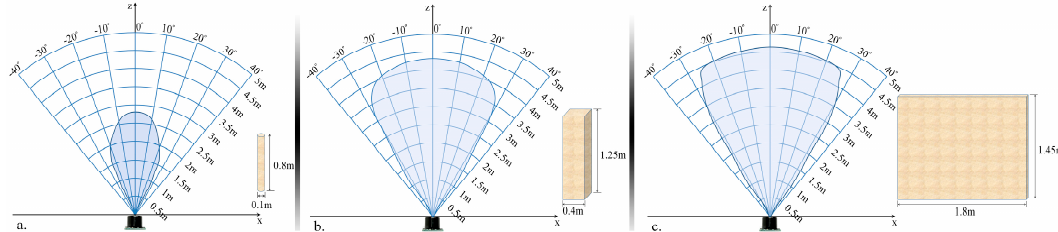
Figure 6. Evaluation of the sensor sonar field of view using: ( a ) a cylinder (10 cm diameter and 85 cm height); ( b ) a box (40 cm width and 125 cm height); ( c ) a panel (180 cm width and 145 cm height).